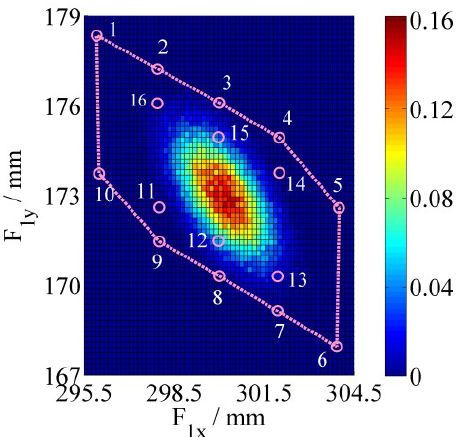
Figure 22. The simplified boundary and the simulation for point F 1